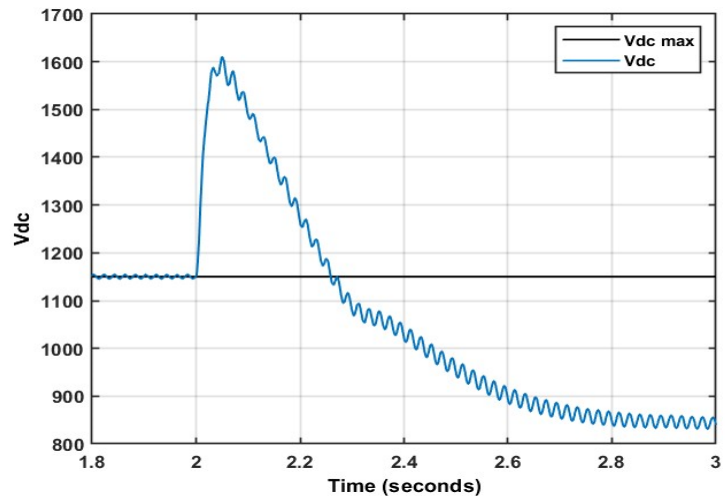
Figure 14. DC voltage transient using PSO at 80% dip.